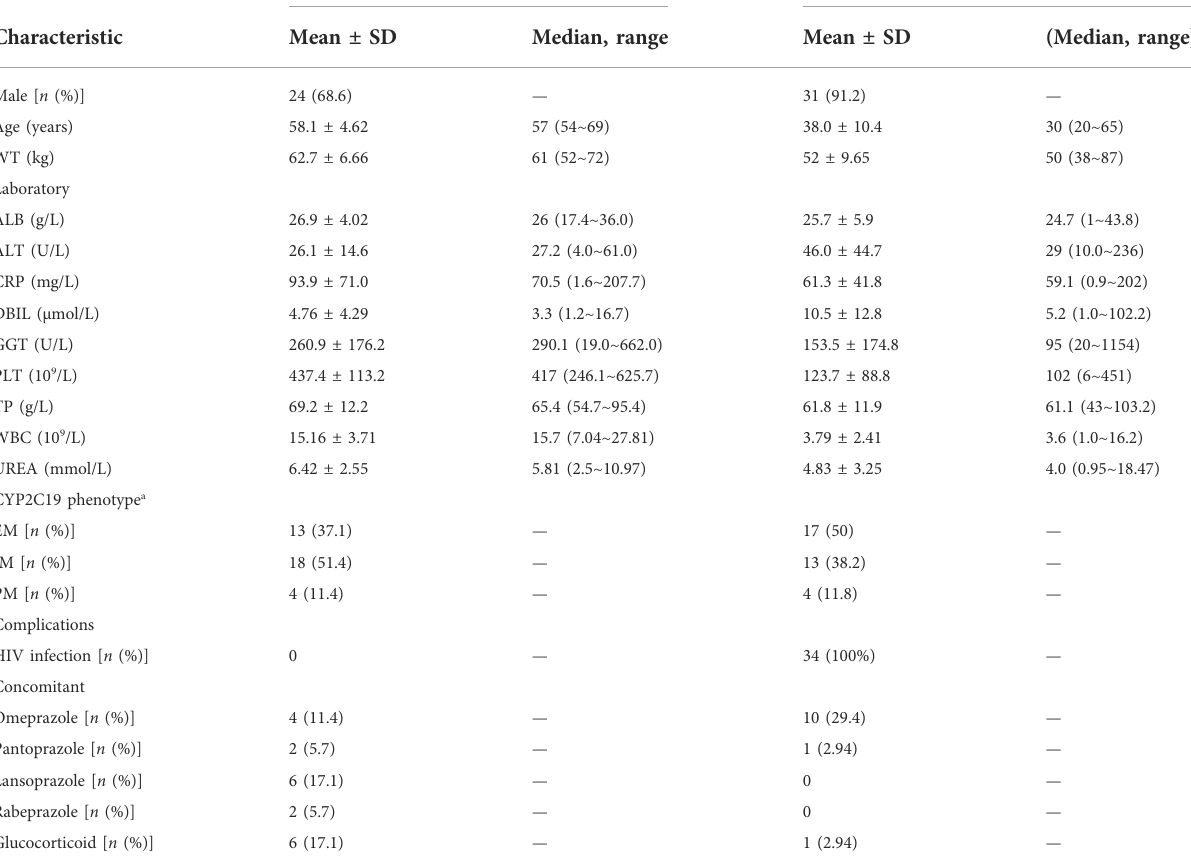
TABLE 1 Patient demographic characteristics and laboratory